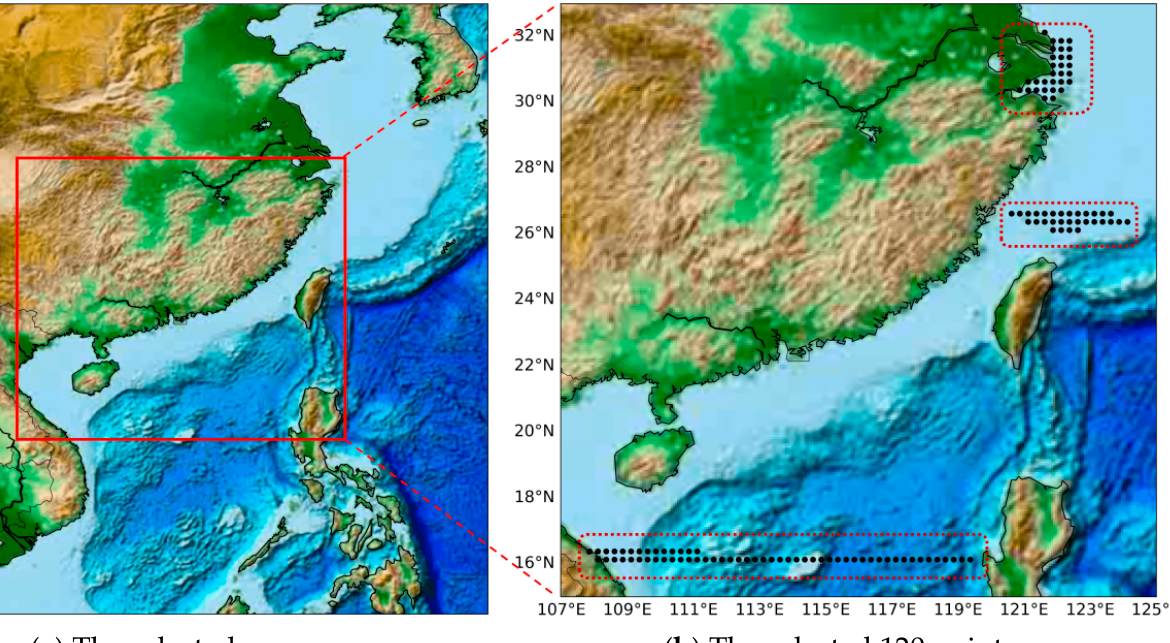
Figure 4. Experiment area.